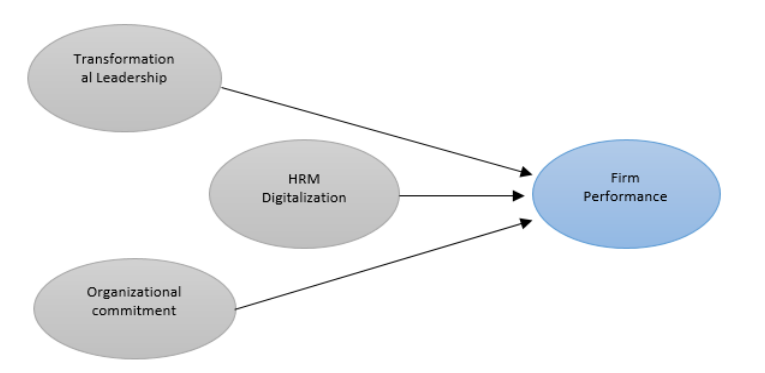
Figure 1: Conceptual